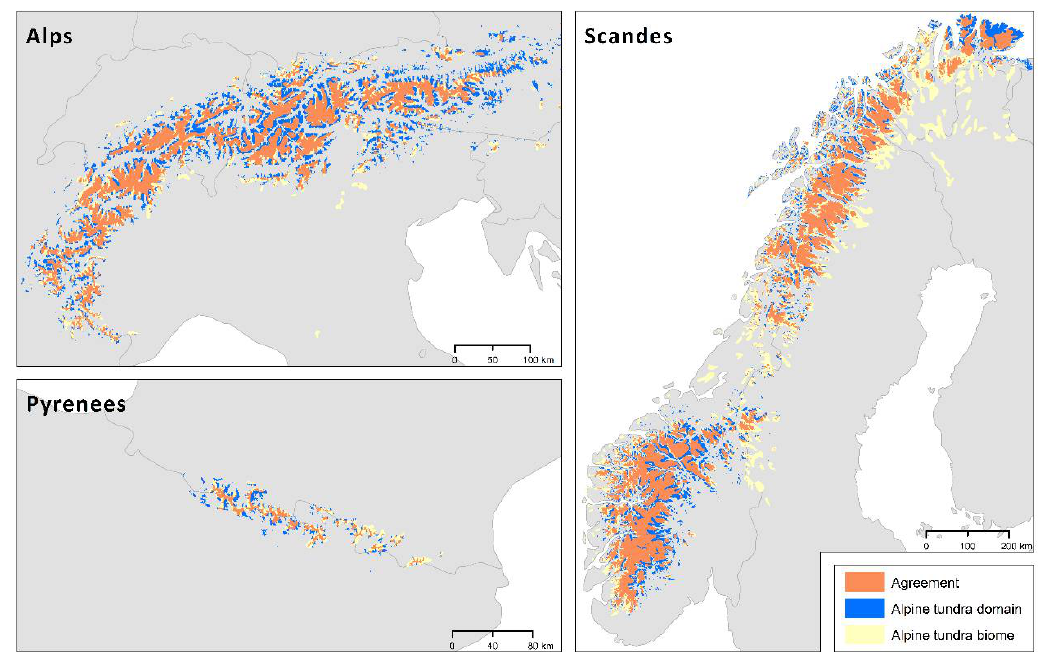
Figure 2. Comparison between the alpine tundra domain (ATD) delineated using climate data from WorldClim (Version 1.4) at a 1-km grid size [48] and the alpine tundra biome (alpine vegetation, subnival vegetation of high mountains and glaciers) according to Bohn et al. [45]. Agreement represents coincident areas in the two